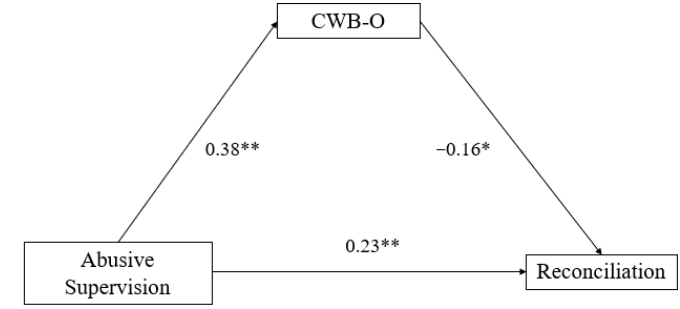
Figure 2. Mediation Test.